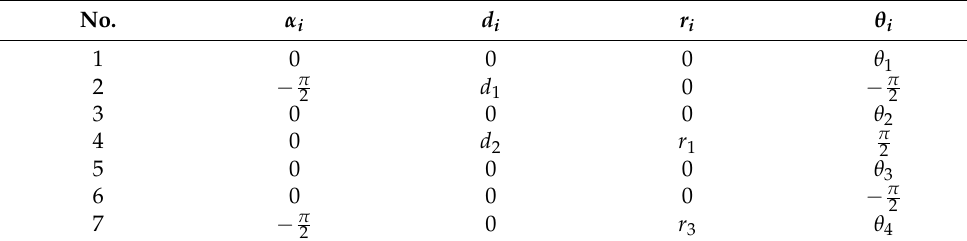
Table 1. Partial parameter table of D-H to IMU-3